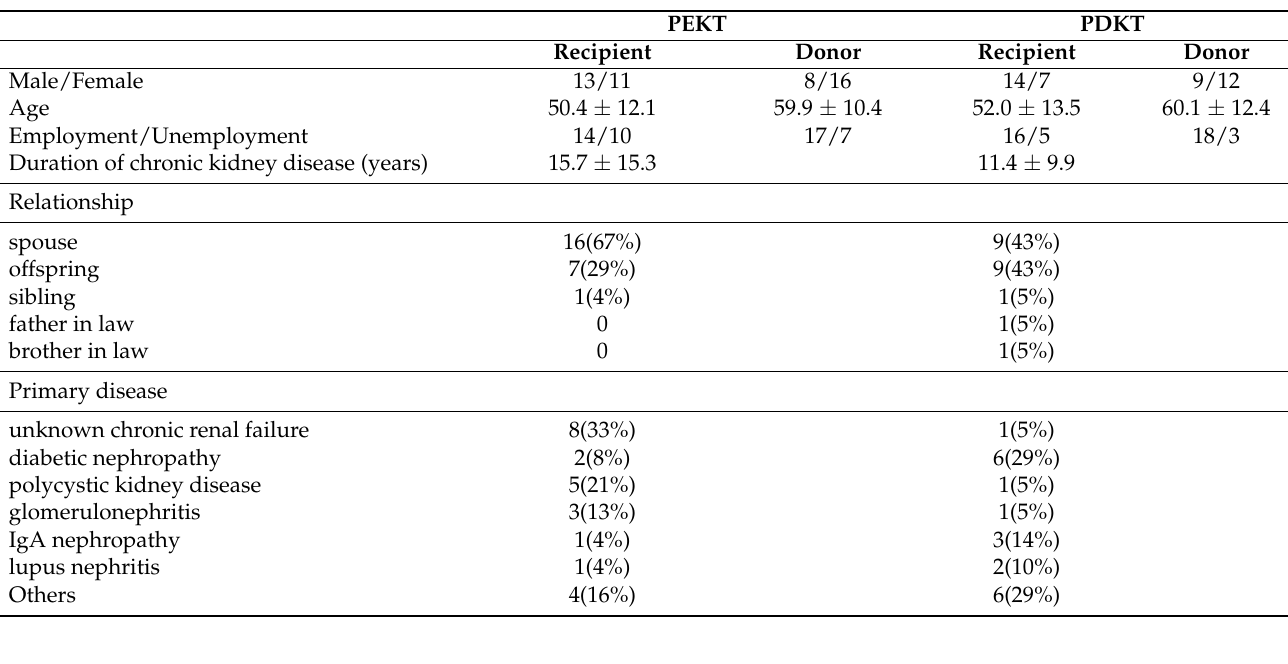
Table 1. Background of subjects in this study. PEKT: Pre-emptive kidney transplantation. PDKT: post-dialysis kidney transplantation. The statistical p values were analysed using a two-way ANOVA (age), a Mann–Whitney U test (duration of chronic kidney disease), a Cochran–Armitage test (relationship and primary disease), and the Cochran–Mantel–Haenstzel method (gender and employment).